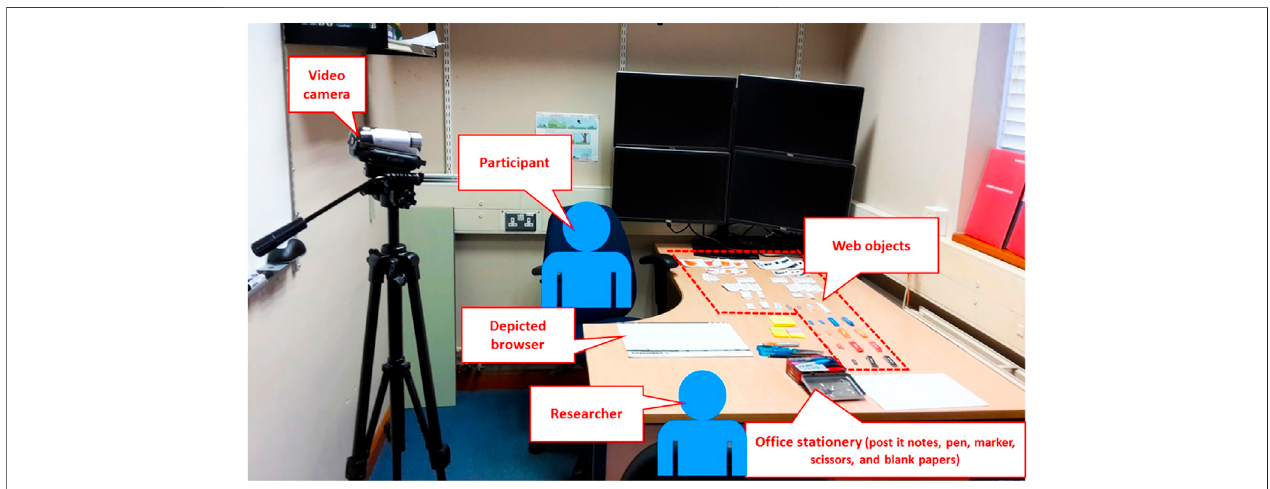
Frontiers in Computer Science |